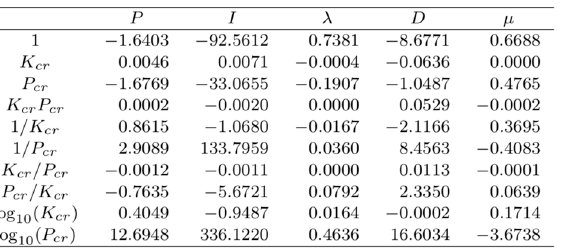
Figure 8. Parameters for the third set of tuning rules for processes with critical gain and period ( P =